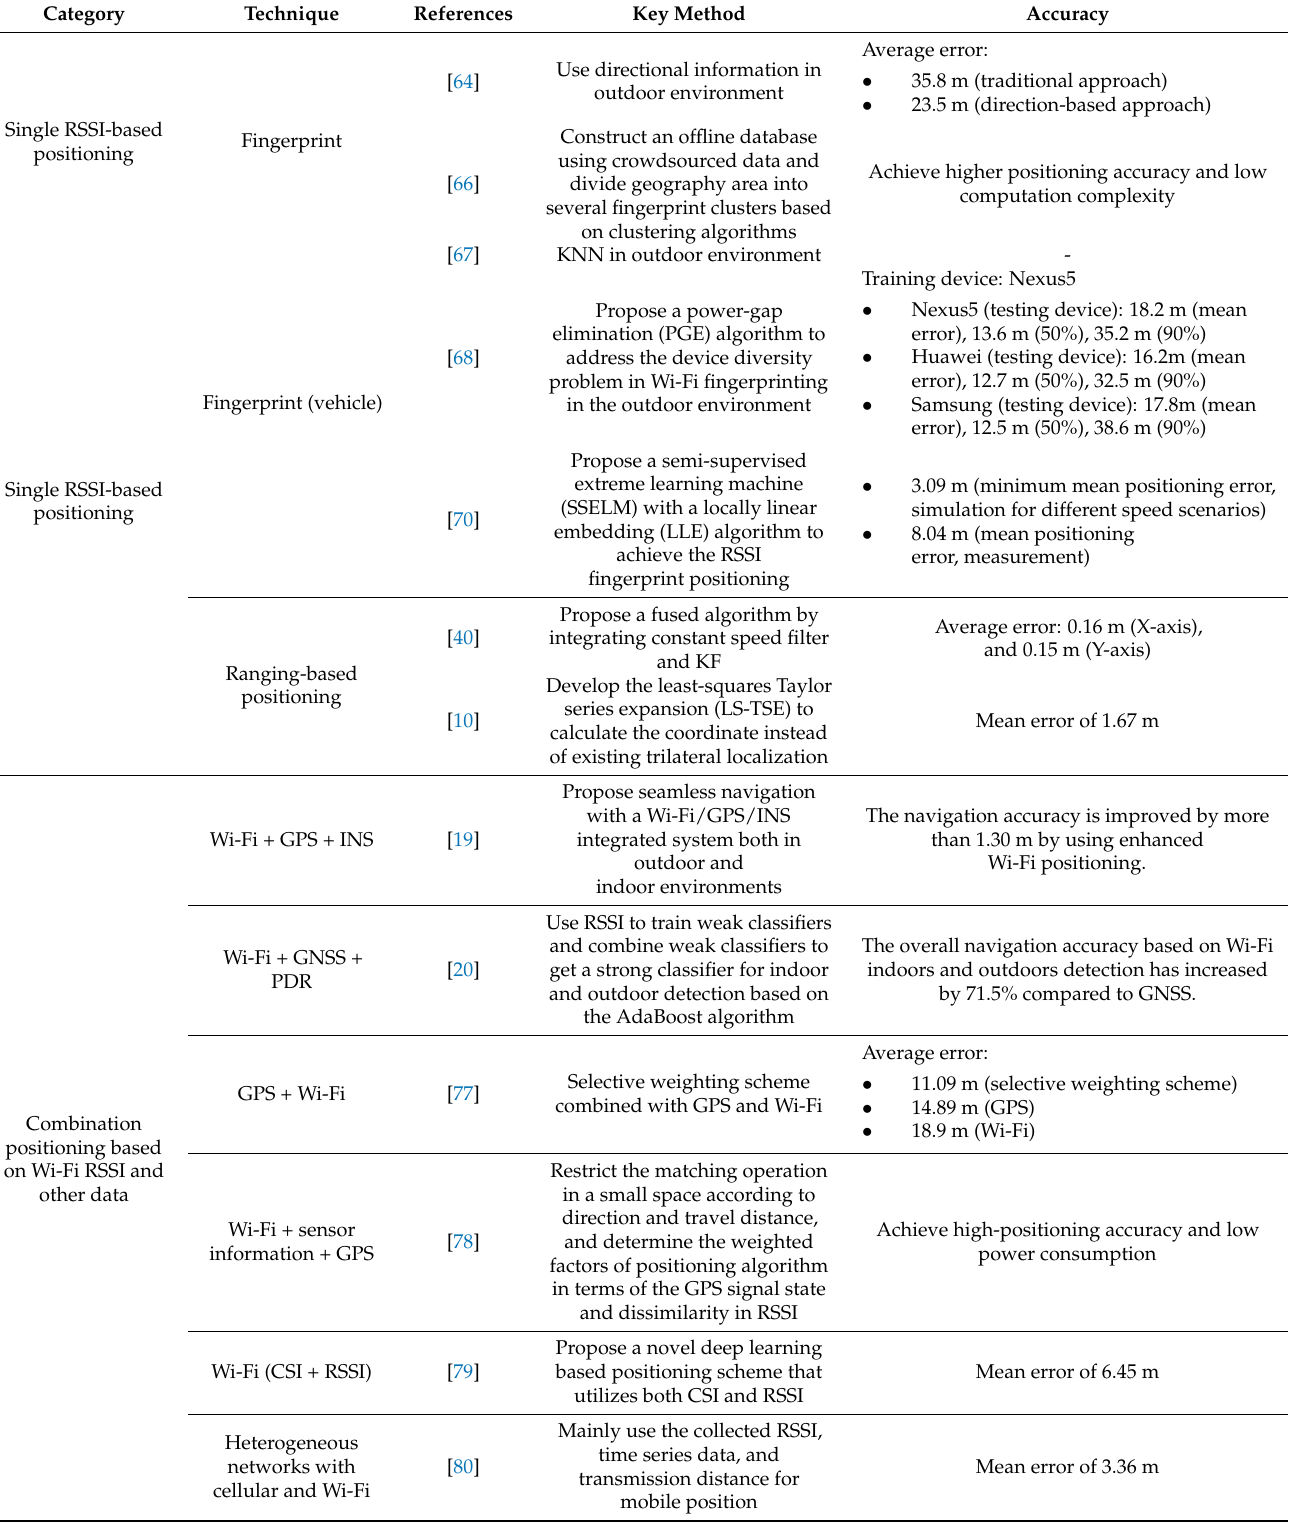
Table 2. Summary of traffic target positioning technologies based on Wi-Fi and